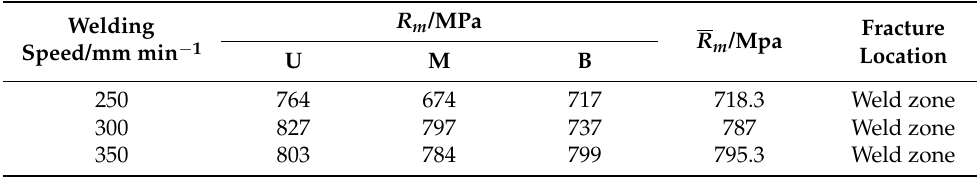
Table 5. Tensile properties of the welded